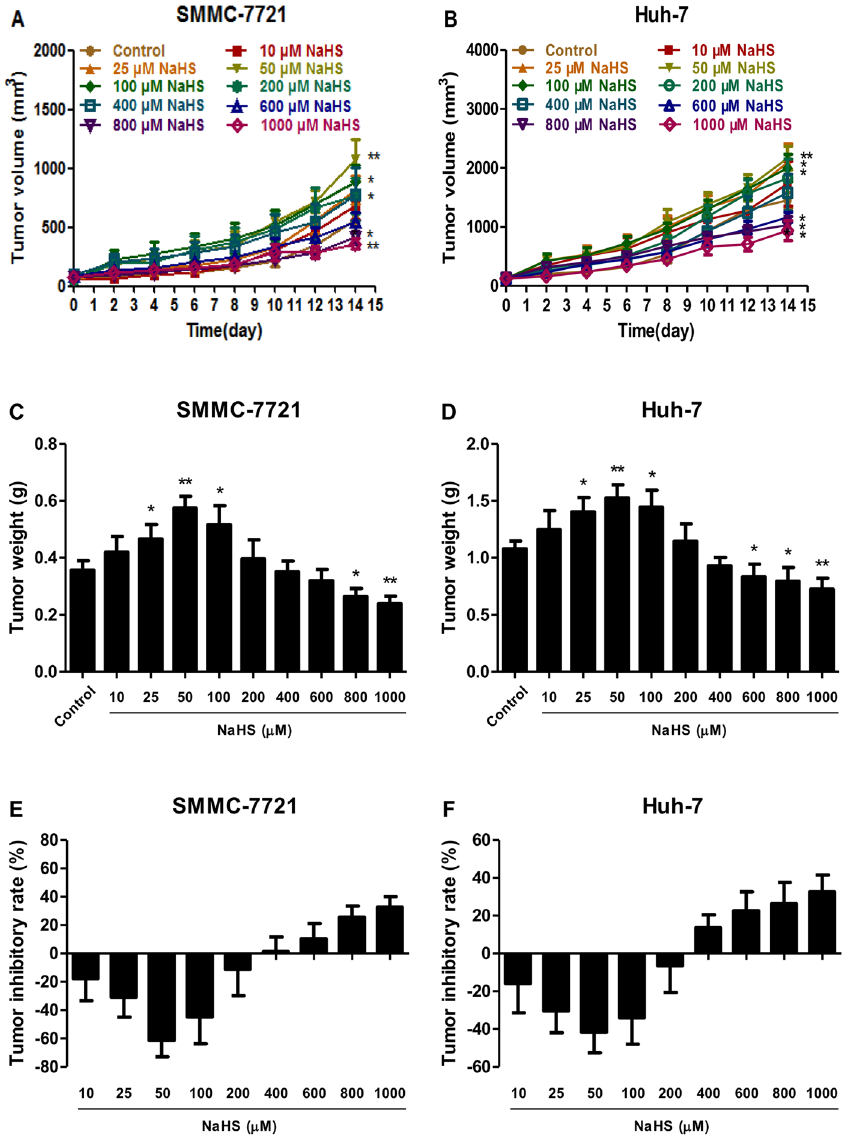
Figure 7. Effect of H 2 S on the growth of SMMC-7721 and Huh-7 xenograft tumors in nude mice. ( A and B ) The tumor volume was measured every day and calculated according to the equation: tumor volume = length × width 2 /2. ( C and D ) At the end of the experiment (day 14), the tumors were harvested and weighed. ( E and F ) The tumor inhibitory rate was calculated. Values are presented as mean ± SEM (n = 6); * P < 0.05, ** P < 0.01 compared with the control